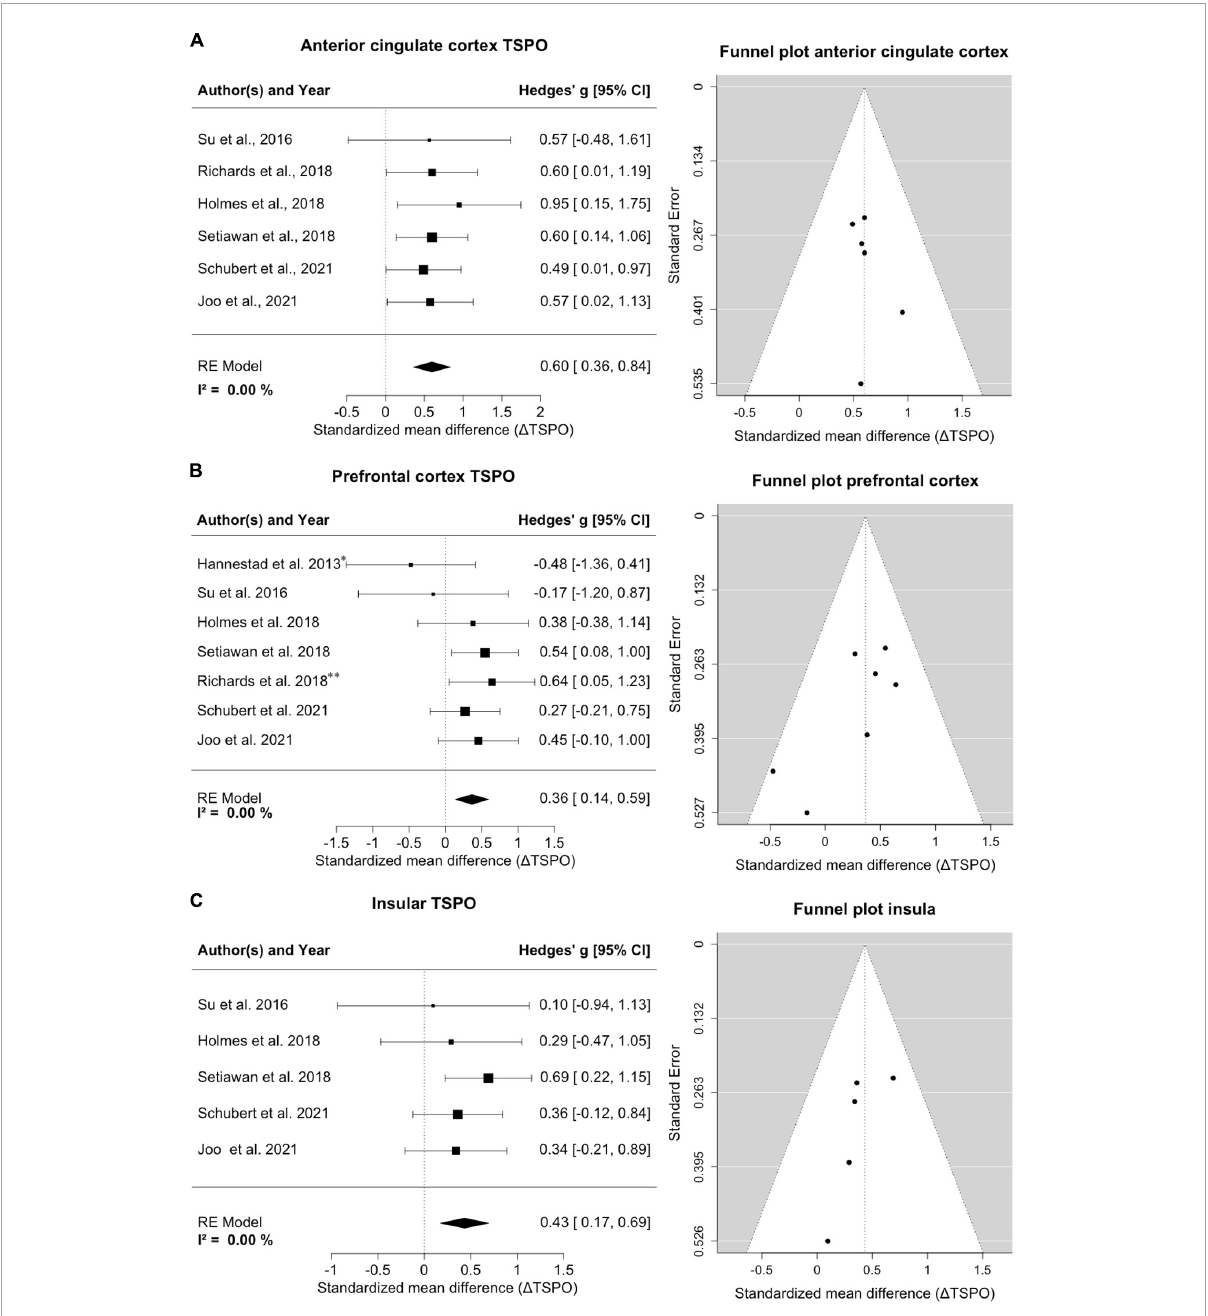
FIGURE2 Significant increase of TSPO binding in anterior cingulate cortex (ACC), prefrontal cortex (PFC) and insula in MDD patients. (A) A forest plot of TSPO binding in the ACC clearly shows an effect size of 0.60, 95%CI: (0.36, 0.84). The corresponding funnel plot is displayed on the right. (B) The forest plot of TSPO in PFC displays an effect size of 0.36, 95%CI: (0.14, 0.59). ∗ Data of frontal cortex; ∗∗ data of subgenual prefrontal cortex. On the right is the funnel plot of estimates of prefrontal cortex. (C) A forest plot for TSPO binding in the insula shows an effect size of 0.43, 95%CI: (0.17, 0.69). Alongside the corresponding funnel plot is